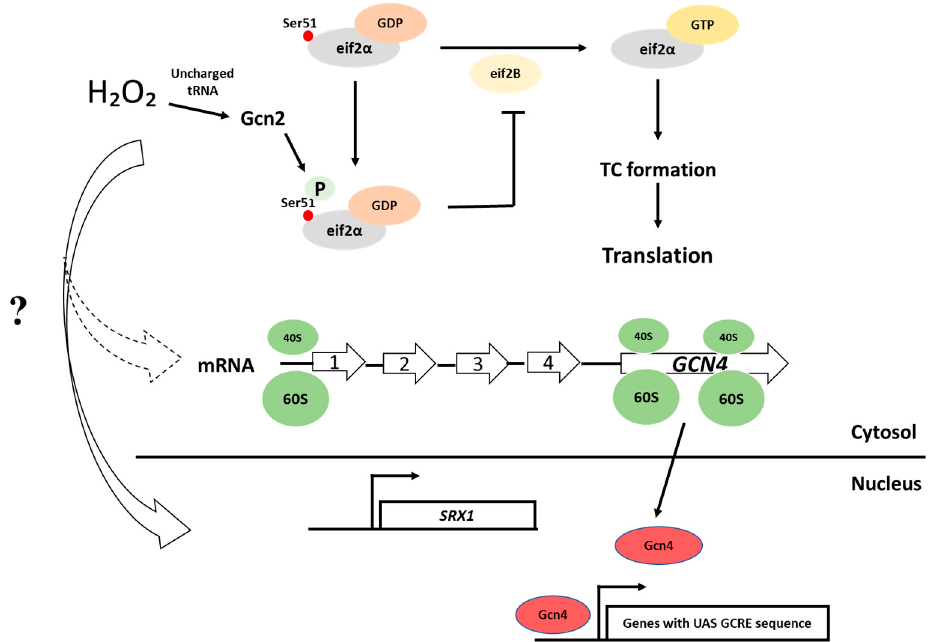
Figure 2. Impact of H ₂ O ₂ on translation initiation. Integrative stress response. Under H ₂ O ₂ , eIf2 α is phosphorylated by Gcn2, ternary complex levels decrease and translation is inhibited. Moreover, the translation of GCN4 , a transcription factor that activates gene expression in response to stress, may be activated, at least in the divergent w303 yeast strain background [63]. In addition, upon Gcn2 activation, sulfiredoxin, Srx1, is more efficiently translated upon addition of H ₂ O ₂ to cells grown under caloric restriction